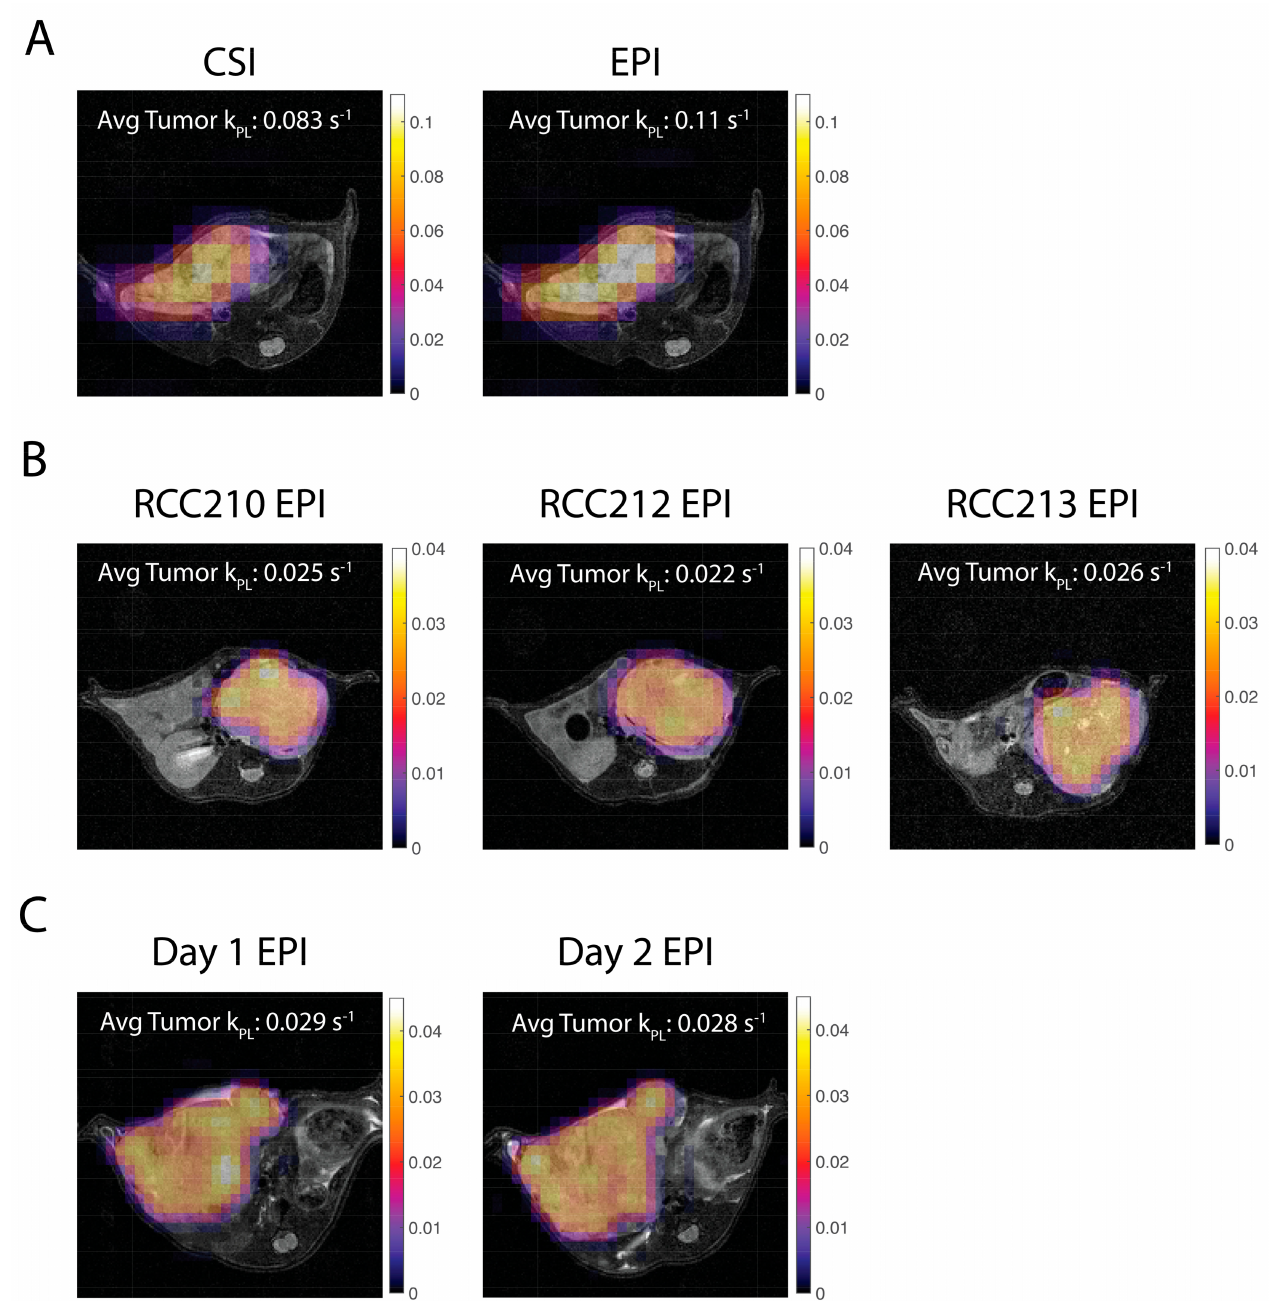
Figure 6. Pharmacokinetic model fits of k PL for in vivo mice overlaid on 1 H T2 RARE images. ( A ) CSI and EPI k PL maps are consistent for the same mouse with an LTL liver tumor. ( B ) EPI k PL maps are consistent for three different mice with RCC tumors. ( C ) EPI k PL maps are consistent for the same mouse with an LTL liver tumor imaged on two consecutive days. All k PL values are as expected and similar to a previous in vivo study